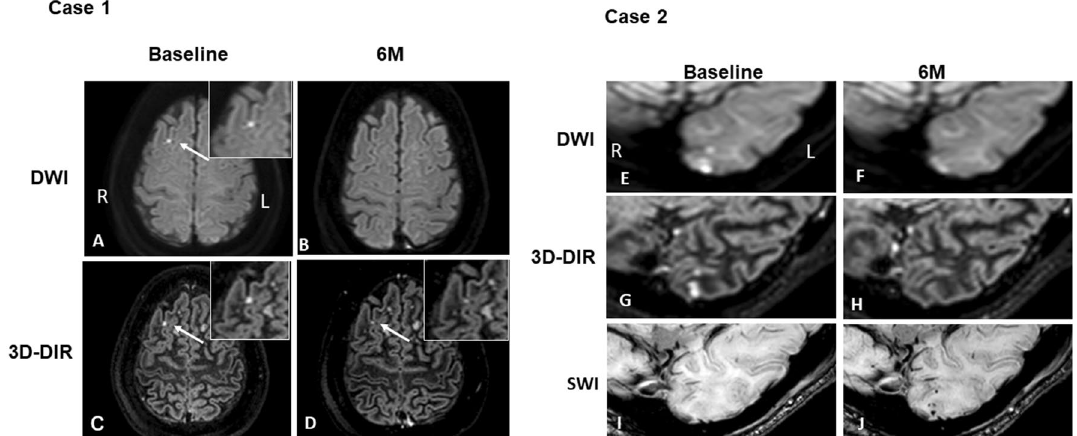
Figure 2. Brain MR images. Case 1: Brain MR images of a female patient. DWI ( A , B ), 3D-DIR findings at baseline ( C ) and after 6 months ( D ). An embolic infarct was detected by DWI and 3D-DIR after ablation. In follow-up MRI, the lesion was still detected by 3D-DIR. Case 2: Brain MR images of a male patient. DWI ( E , F ), 3D-DIR ( G , H ), SWI ( I , J ) findings at baseline (left) and after 6 months (right). The embolic microinfarctions detected by DWI and 3D-DIR after ablation disappeared at follow-up, but SWI detected de novo microbleeds exactly at the same location where the infarcts were detected at baseline. DWI Diffusion-weighted imaging, 3D- DIR 3-Dimensional double inversion recovery, SWI Susceptibility-weighted imaging.